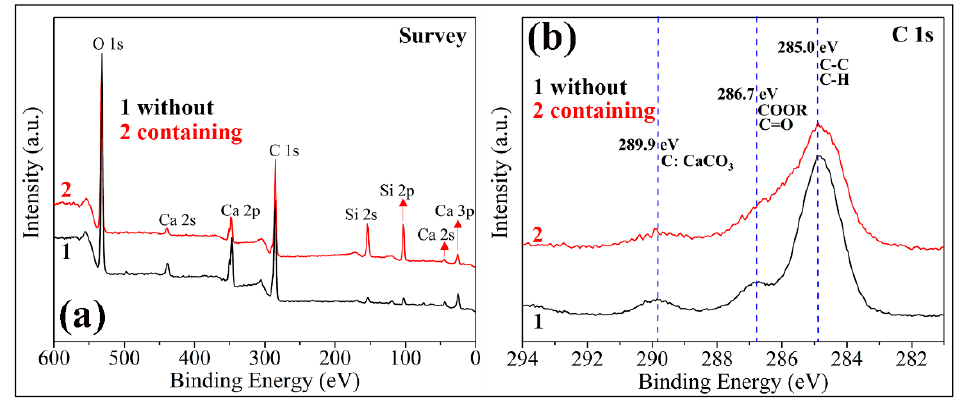
Figure 8. XPS spectra of two kinds of PC coatings (without using hydrophobic emulsion and containing hydrophobic emulsion): ( a ) survey spectra; ( b ) high resolution spectra in C 1s region.